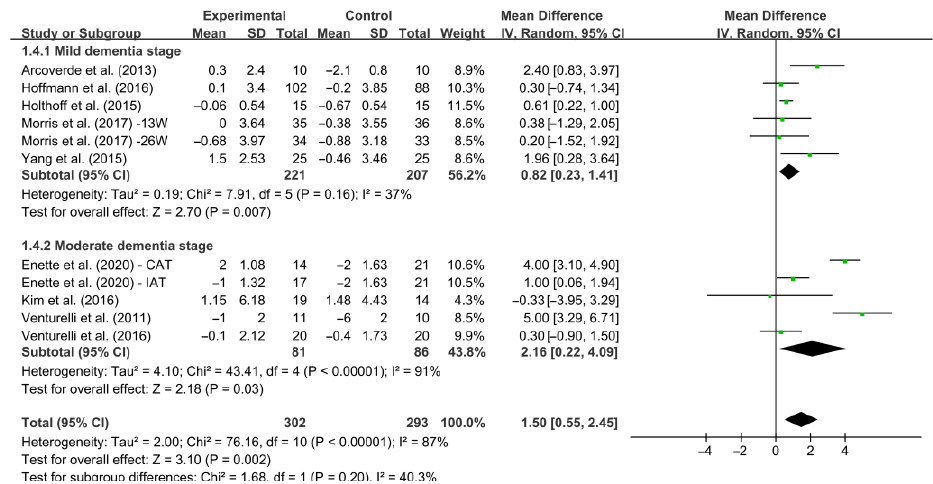
Figure 8. Meta-analysis results of the effect of aerobic exercise on cognitive function in mild or moderate AD patients [20,27,39 – 45].